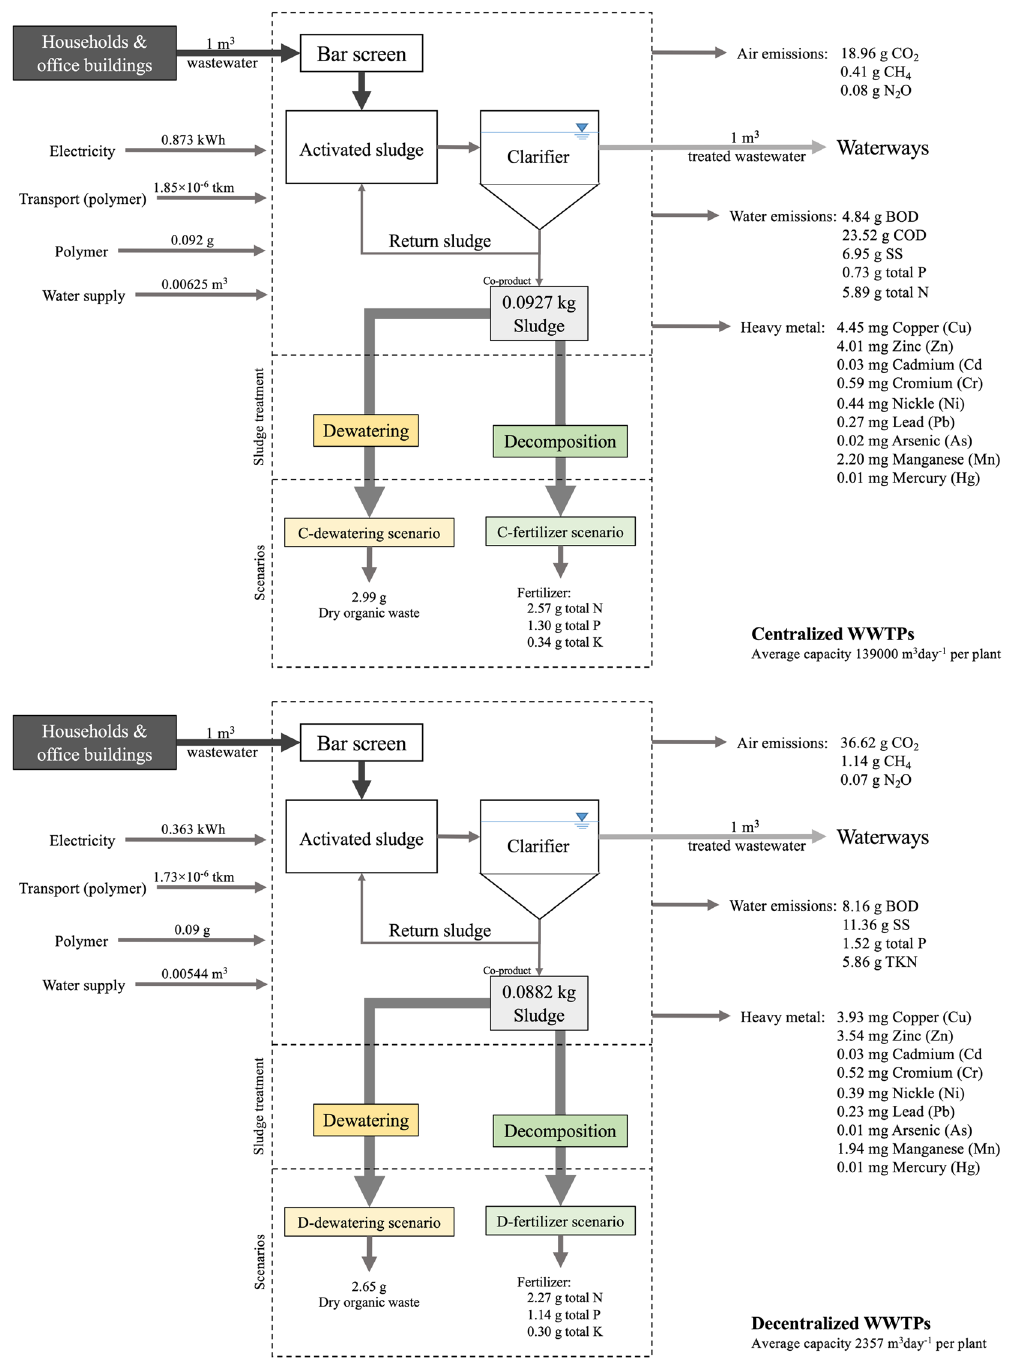
Figure 2. Average inventory data of centralized and decentralized sludge treatment scenarios: C-dewatering, C-fertilizer, D-dewatering and